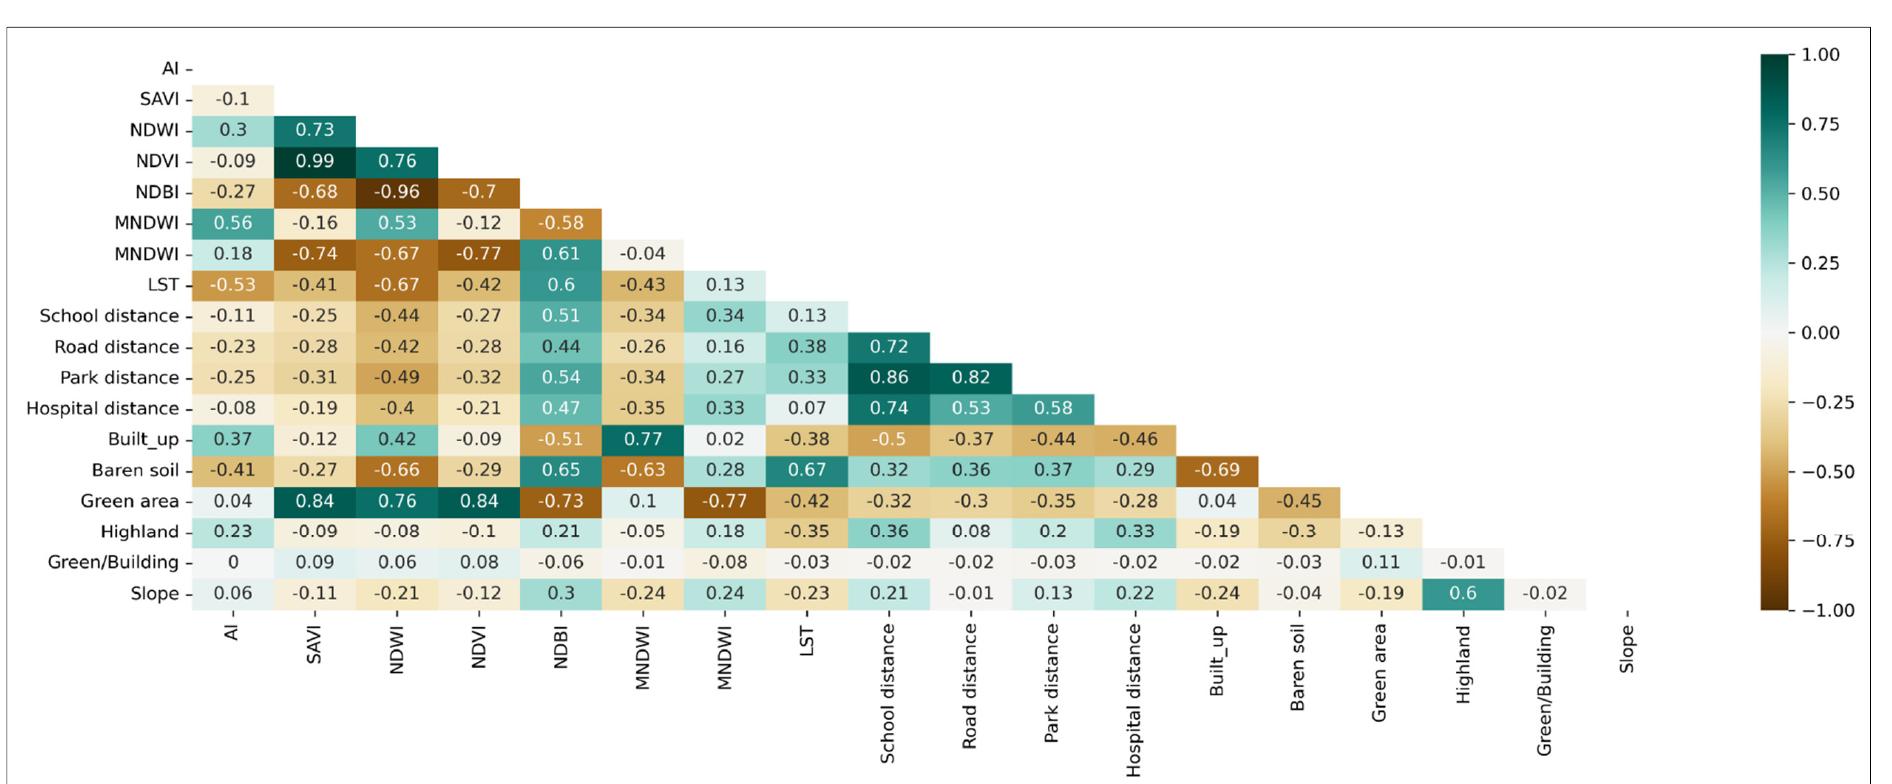
Figure A1. Correlation matrix among the environmental and infrastructure facility variables used for UQoL model.